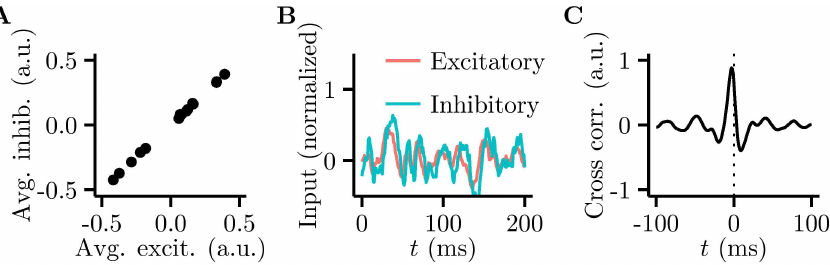
B. Total inhibitoryinput to a single cell (blue) closely tracks but slightly lags total excitatory input (red) over the course of a trial. C. The cross-correlation betweenthe averageexcitatory and averageinhibitorymembrane potentials shows a peak that is offset from 0